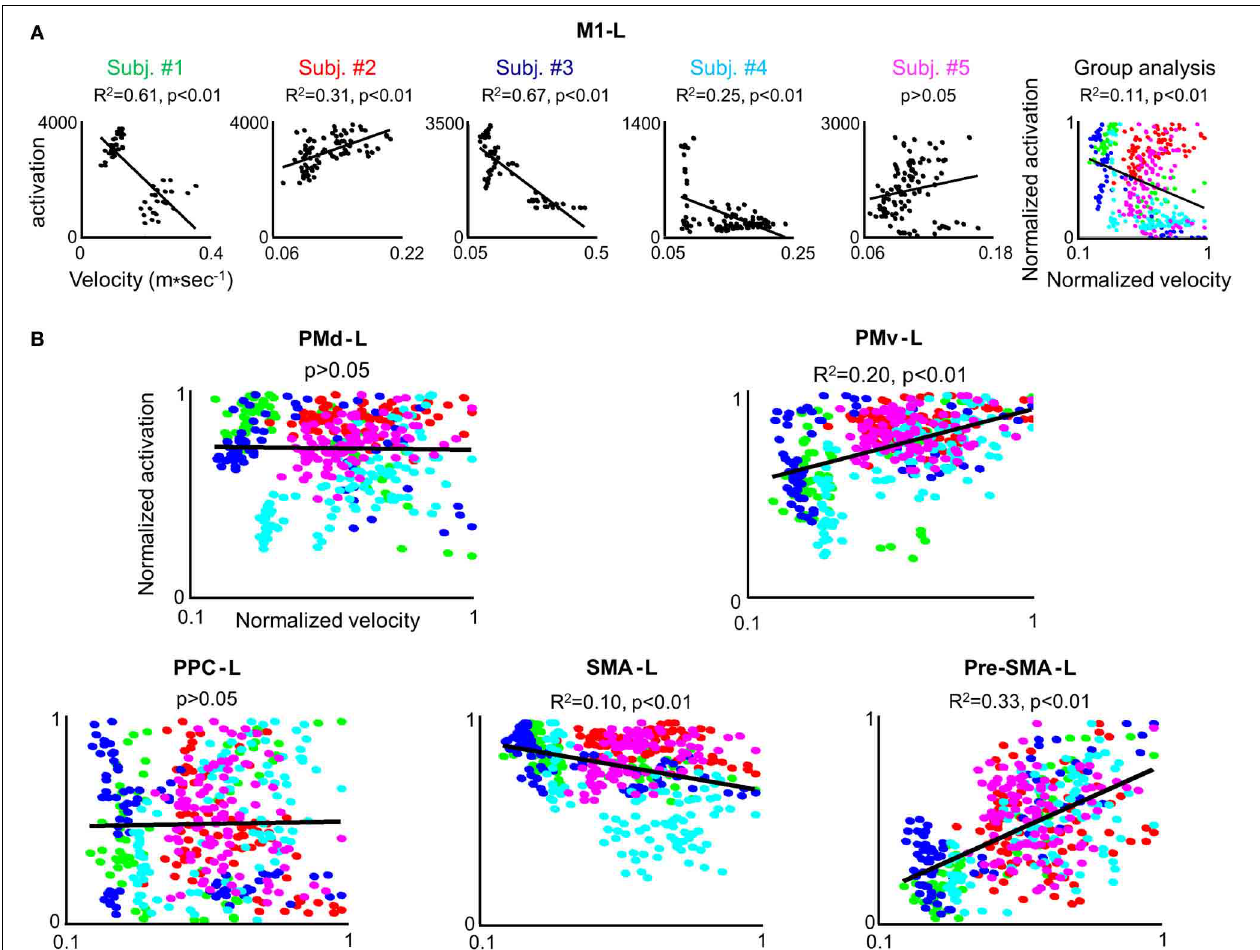
FIGURE 7 | The correlation between the individual amount of M1-L activation and trial mean velocity is modulated by a performance-related effect. (A) For each subject the amount of M1-L activation vs. trial mean velocity while training on the three tested conditions in the 3 scanning days is depicted. The correlation coefficient and the significance level (R 2 and